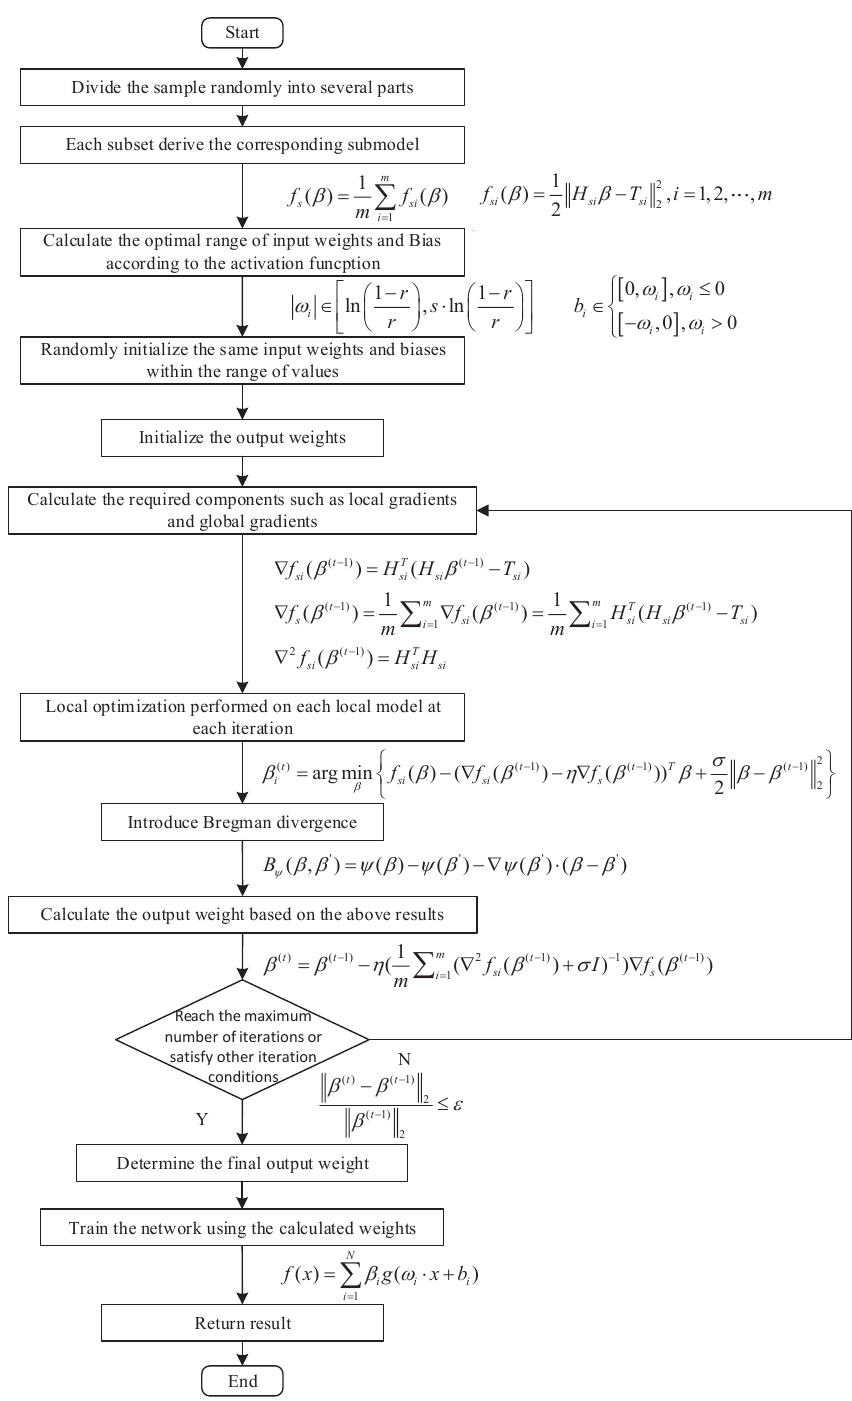
Figure 4. An optimized FNNRW learning algorithm flowchart. The graphic depicts each phase of the FNNRW optimization process, and the chosen approach corresponds to that step specifically. The flow chart may be used to more clearly illustrate the improved FNNRW algorithm’s execution process, condition judgment at its start, and condition at its